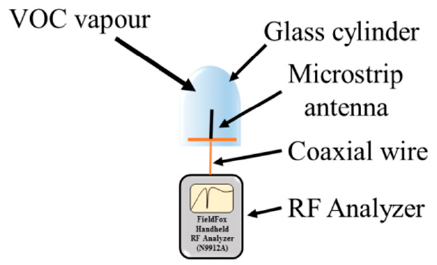
Figure 5. A schematic drawing of the proposed system for the measurement of the frequency de- pendence of the reflection coefficient by a sensor.